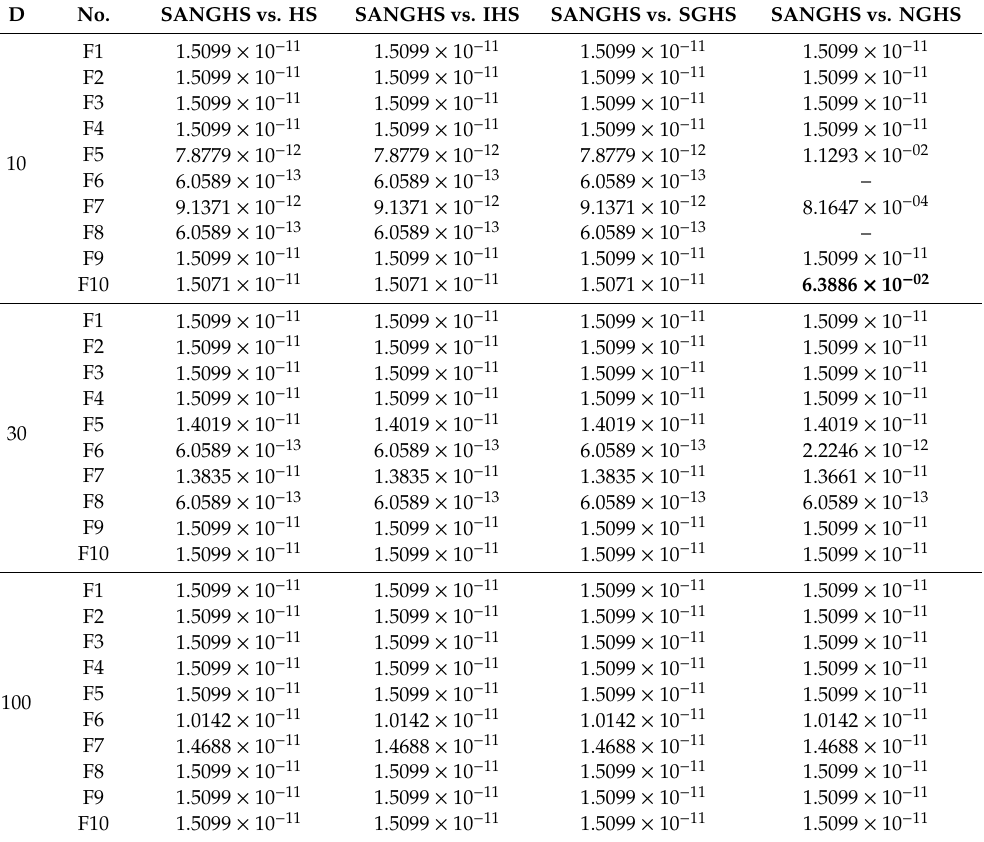
Table 5. p -value of Wilcoxon rank-sum test in ten